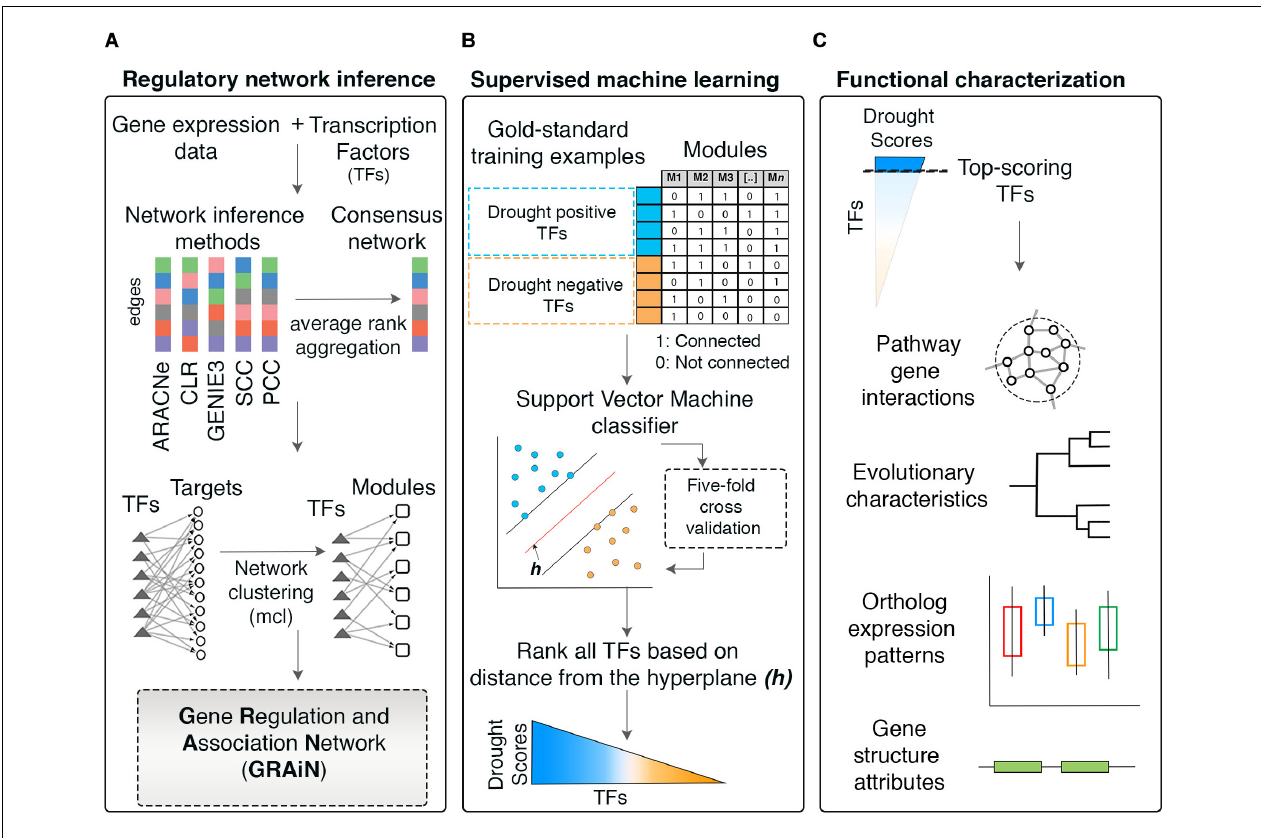
FIGURE 1 | Workflow of the network-based machine learning framework developed in this study. (A) A gene regulatory network (GRN) depicting regulatory relationships between transcription factors (TFs) and potential target genes was inferred from large-scale expression data (microarrays) of rice. An ensemble of network prediction algorithms was applied to the data and the networks inferred by different algorithms were statistically combined using the average rank aggregation method, resulting in a single consensus gene regulatory network. This network then was clustered using a network clustering algorithm to identify modules of coregulated, and, therefore, functionally associated genes. This modular core of the network was then reconciled with the GRN core, resulting in weighted assignments of TFs as the potential regulators of the modules. The network was named Gene Regulation and Association Network (GRAiN). mcl, Markov clustering algorithm. (B) Several rice knowledgebases and the literature were mined to obtain a list of TFs that are experimentally validated and reported as regulators of drought response phenotypes in rice. We found 165 such TFs reported to date. We regarded these TFs as the ‘gold standard’ examples of drought resistance (DR). All DR TFs were labeled as the ‘drought positive’ class. The group of TFs that did not differentially express in our reanalysis of several published drought experiments were labeled as the drought negative class. These benchmark drought TFs (positive and negative class), along with their network connectivity patterns in GRAiN, were used as input to train a binary classification algorithm, the support vector machine (SVM). The SVM learnt unique network patterns that can discriminate between the two classes of benchmark TFs. These patterns were fivefold cross-validated and subsequently used to predict the class label (positive or negative) of the remaining unlabeled TFs (ones that are neither in the positive nor the negative class). The final model’s output was used to represent each TF in GRAiN (2160 total) along a continuous spectrum (called drought scores), representing its potential association with drought resistance. (C) The functional, evolutionary, and genomic features unique to most TFs at the top end of the drought score spectrum were identified and described. GRAiN and predictions on regulators of DR can be freely accessed online at